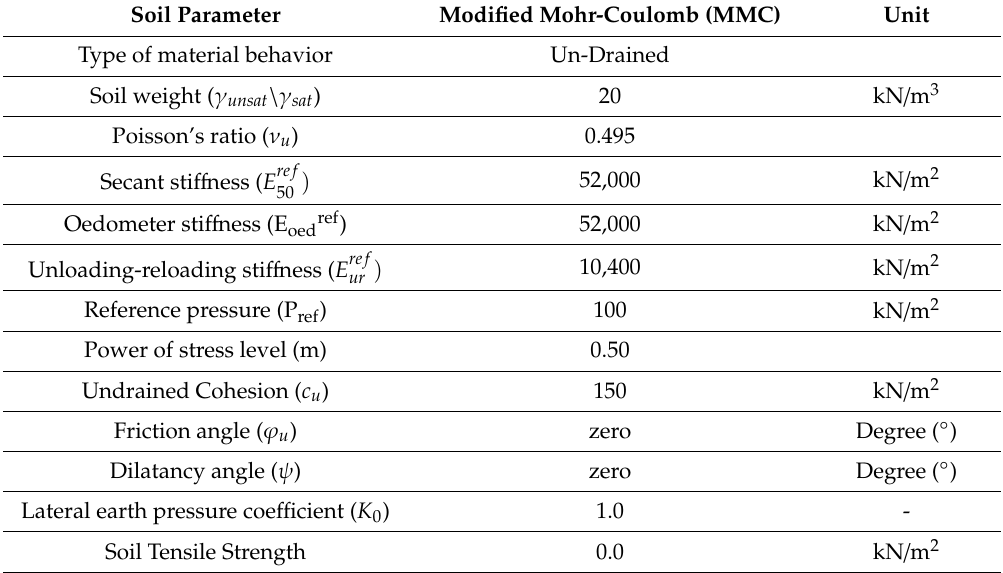
Table 3. Over consolidated sti ff clay undrained soil